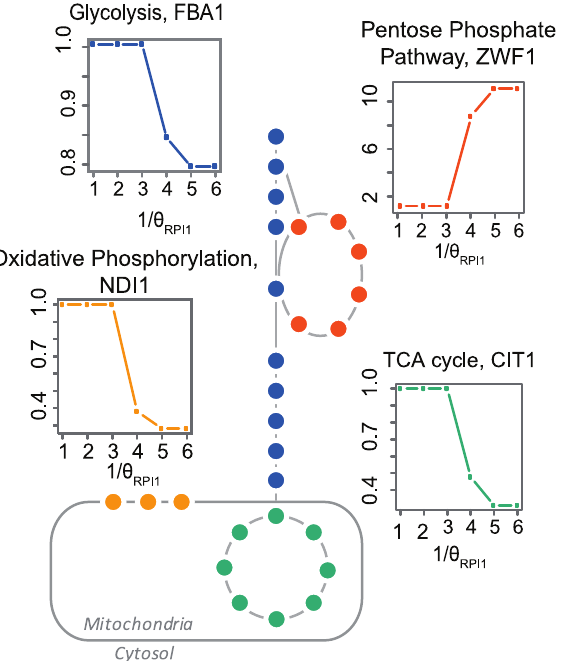
Figure 1. Minimization of overall intracellular flux leads to divergent predictions for flux distribution when using bio- chemically equivalent stoichiometry representations. Shown are predicted fluxes through key pathways within the S. cerevisiae central carbon metabolism, using numerically different but biochemically equivalent stoichiometric representation of reaction RPI1 ( h RPI1 , Methods ). h RPI1 is represented on the x-axis, while fold-change of fluxes relatively to h =1 is represented on the y-axis. A representative reaction from each of the pathways was selected to illustrate the flux re- arrangement; FBA1 for glycolysis, ZWF1 for pentose phosphate pathway, CIT1 for tricarboxilic acid cycle and NID1 for oxidative phosphorylation. Note that h =1 is an arbitrary reference, as the stoichiometric representation of any reaction is subjective, often scaled to have coefficient of 1 for one of the reactants/products.